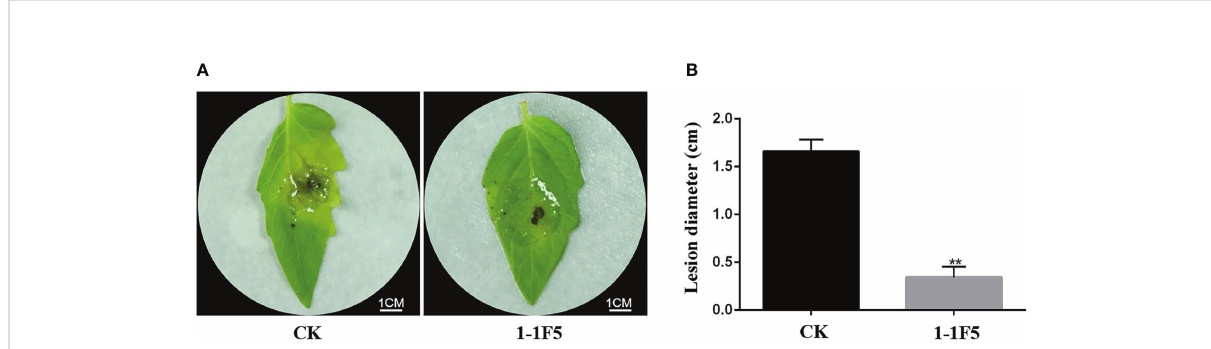
FIGURE 1 Effects of 1-1F5 on tomato leaves inoculated with B.cinerea . (A) Phenotype of the systemic leaves of tomato at 3 DAI with B. cinerea . CK and 1- 1F5 are respectively the inoculation of B. cinerea after the in fi ltration of ddH 2 O and 1-1F5 supernatant into tomato leaves; (B) Lesion diameter of tomato at 3 DAI with B. cinerea , asterisks indicate statistically signi fi cant differences (** p <